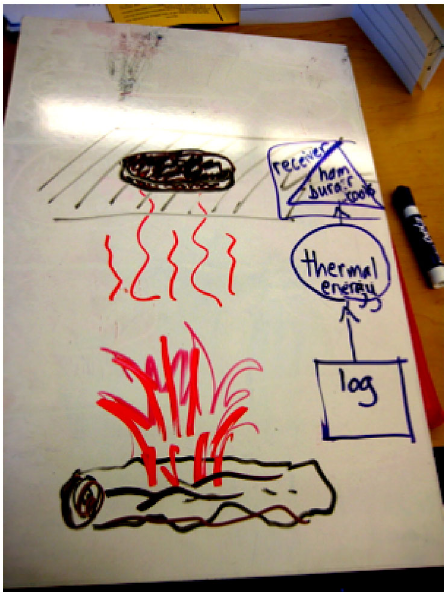
FIG. 2 (color online). Learner-generated diagram for a ham- burger cooking over a fire, inspired by PET energy diagrams.